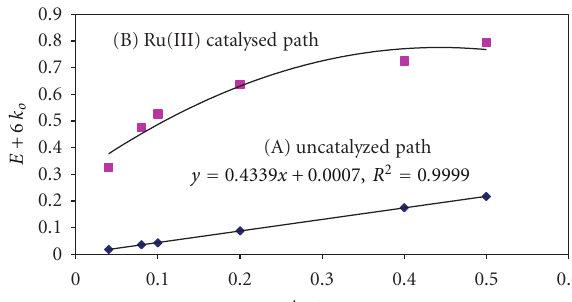
Figure 1: Plot of k o versus [acetone] in NBS-acetone reaction 10 2